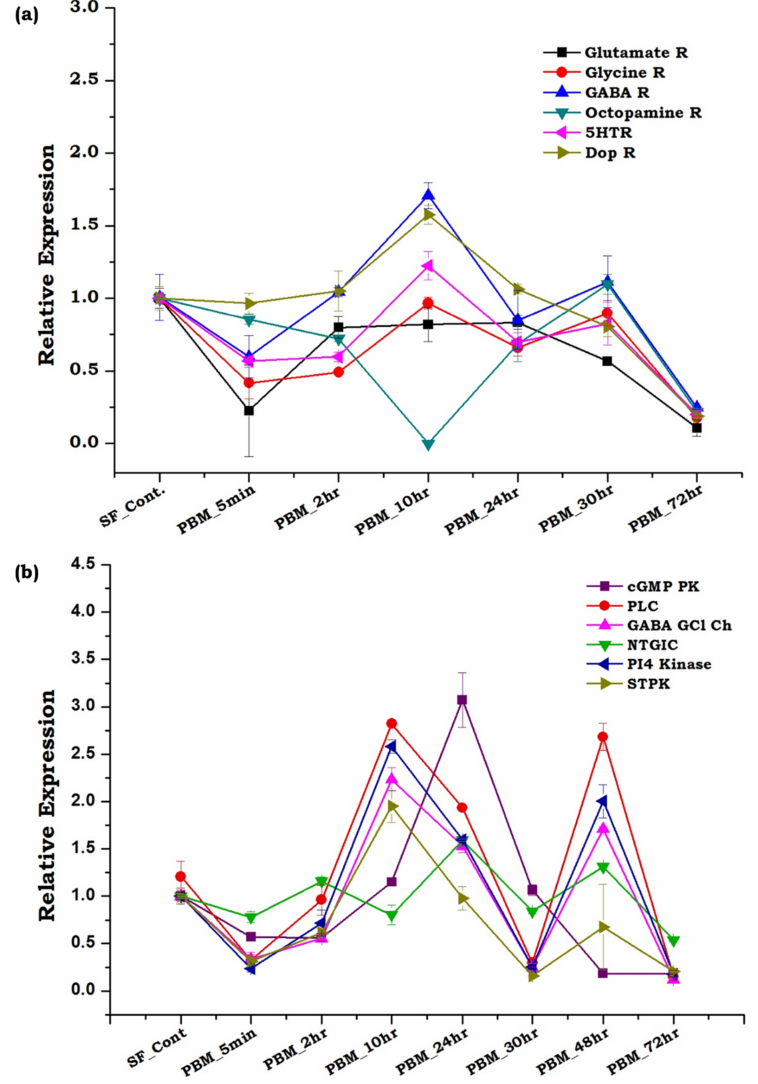
Figure 2. Metabolic switch influences neuro-signaling modulation and inter-organ communication. ( a ) Transcriptional response of neurotransmitter receptor genes as per the designed blood meal time-series experiment. Brain tissues were collected from 5–6 day old naïve sugar-fed adult female mosquitoes. Then, mosquitoes were provided with blood meal, and the brain tissues were collected at different time points after blood feeding viz. 5 min post blood meal (PBM-5 min), PBM-2 h, PBM-10 h, PBM-24 h, PBM 30 h, and PBM-72 h. Glutamate R: Glutamate Receptor; Glycine R: Glycine Receptor; GABA R: Gamma-Aminobutyric Acid Receptor; Octopamine R: Octopamine Receptor; 5 HTR: Serotonin Receptor; Dop R: Dopamine Receptor. Statistical analysis using two-way ANOVA has implied at 0.05 level the expression pattern of the respective genes was not statistically significant at p ≤ 0.2 at different time points after blood feeding ( n = 25, N = 4); ( b ) Relative expression profiling of the genes involved in signal transduction molecules according to the detailed blood meal time-series experiment. cGMP PK: Cyclic GMP Protein Kinase; PLC: Phospholipase C; GABA GClCh: GABA Gated Chloride Channel; NTGIC: Neurotransmitter Gated Ion Channel; PI4 Kinase: Phosphatidyl-inositol-4-Kinase; STPK: Serine Threonine Protein Kinase. Statistical analysis using two-way ANOVA and Tukey’s test stated that the expression change of the respective genes is statistically significant p ≤ 0.05 ( n = 25, N = 4). For Statistical analysis, all the time points and all the transcripts are compared together using two-way ANOVA and the means of the time points are statistically significant. ( n = number of mosquitoes from which the respective tissue was dissected and pooled for each independent experiment; N = number of biological